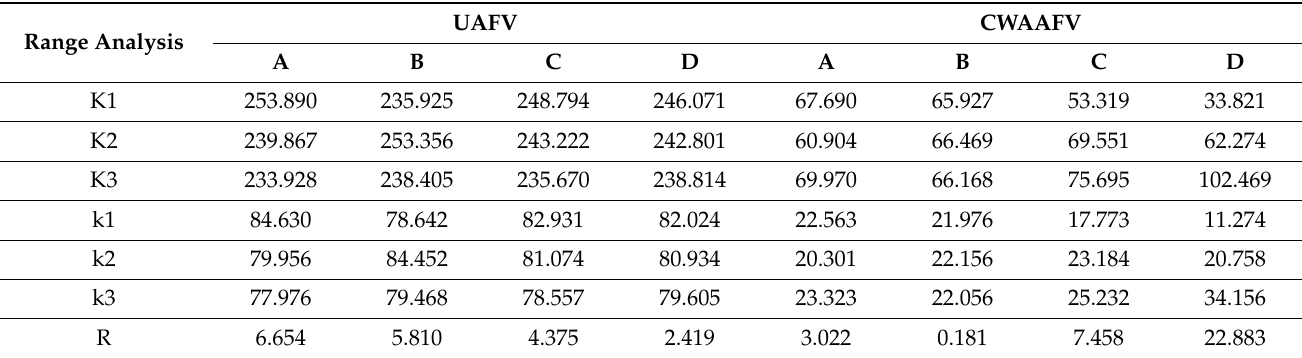
Table 3. Range analysis